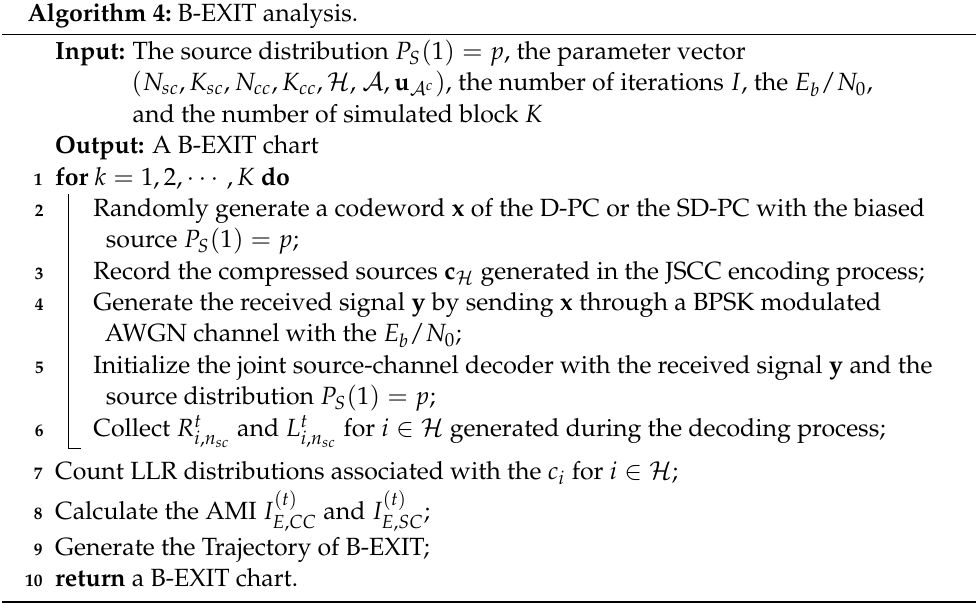
Algorithm 4: B-EXIT